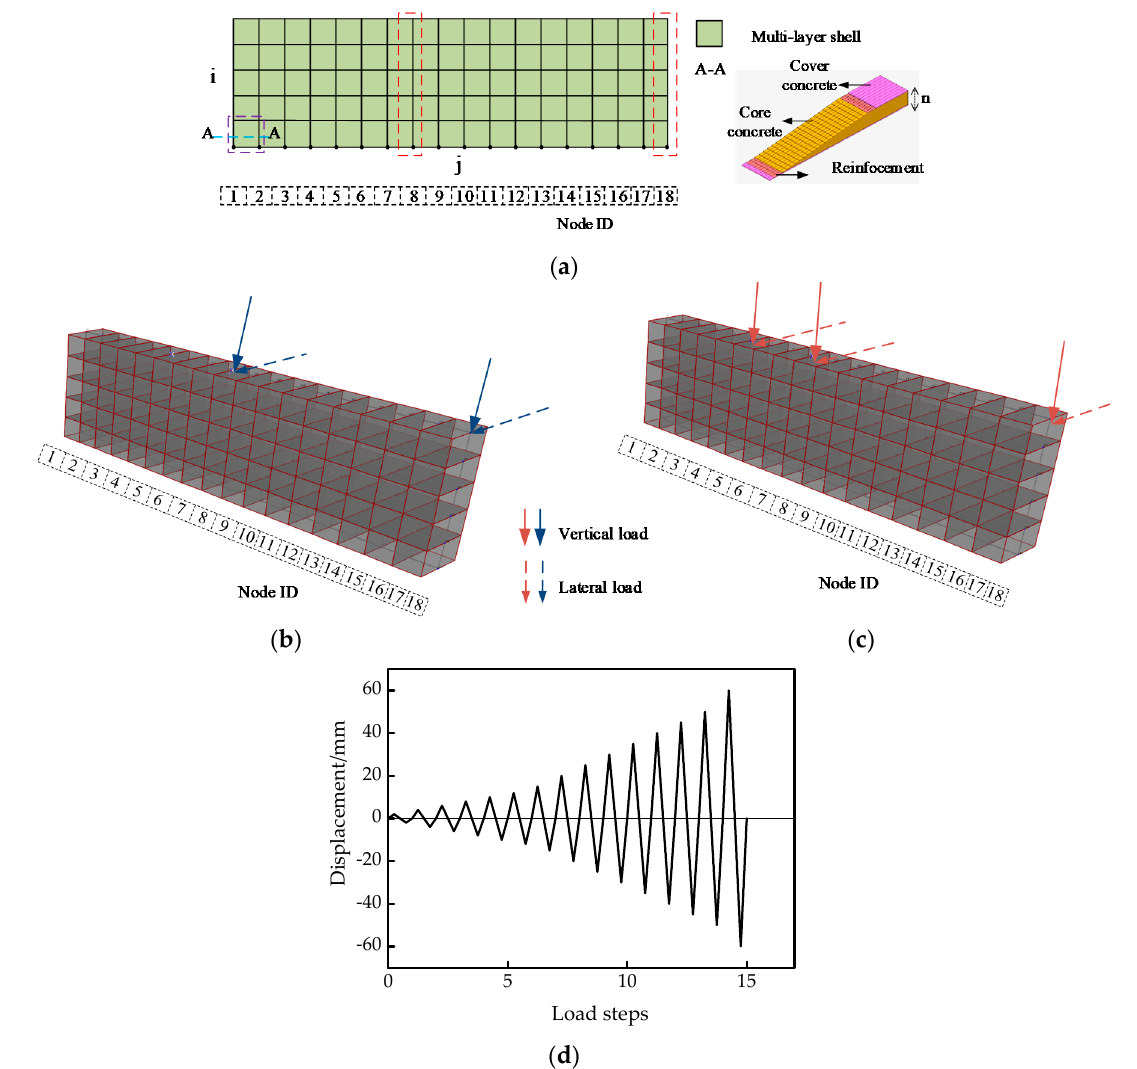
Figure 4. Loading modes of half of multi-layer shell element model: ( a ) Elevation of the wall pier model; ( b ) TestA-2; ( c ) TestA-6; ( d ) Loading protocol.